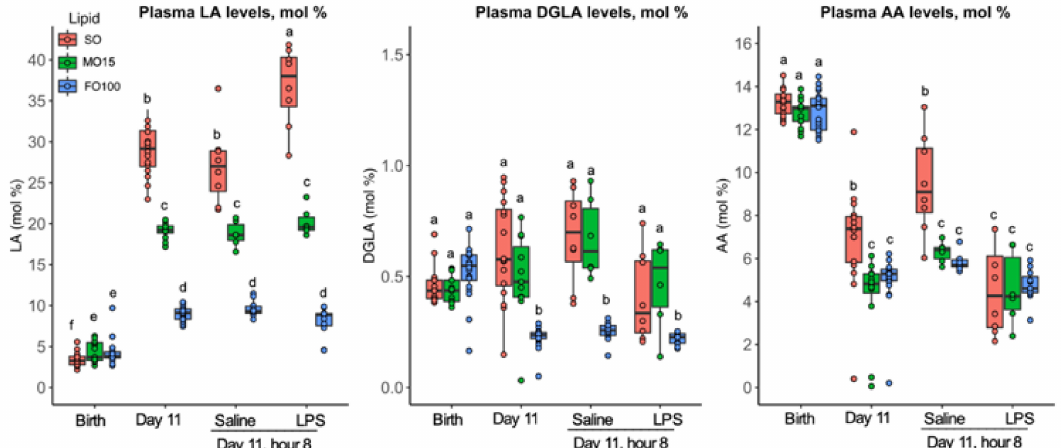
Figure 4. Specific plasma n -6 fatty acid profiles across postnatal age as a function of lipid group. Concentrations of fatty acids were determined by GC-MS and are presented as mol% in the form of boxplots with dots. Data show median and IQR. At day 11, pigs in each lipid group received either LPS or Saline, and fatty acid levels were measured at 8 h at the end of the continuous infusion. Labeled points without a common letter represent a statistically significant difference of p < 0.05. AA, arachidonic acid; DGLA, dihomo- γ linolenic acid; FO100, 100 percent fish oil; LA, linoleic acid; MO15, mixed oil with 15% fish oil; SO, 100% soybean oil.